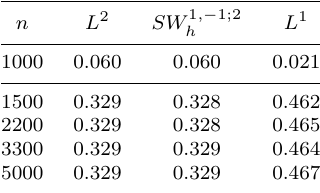
Table 2. Practical errors and error orders in Example A 1 / 2